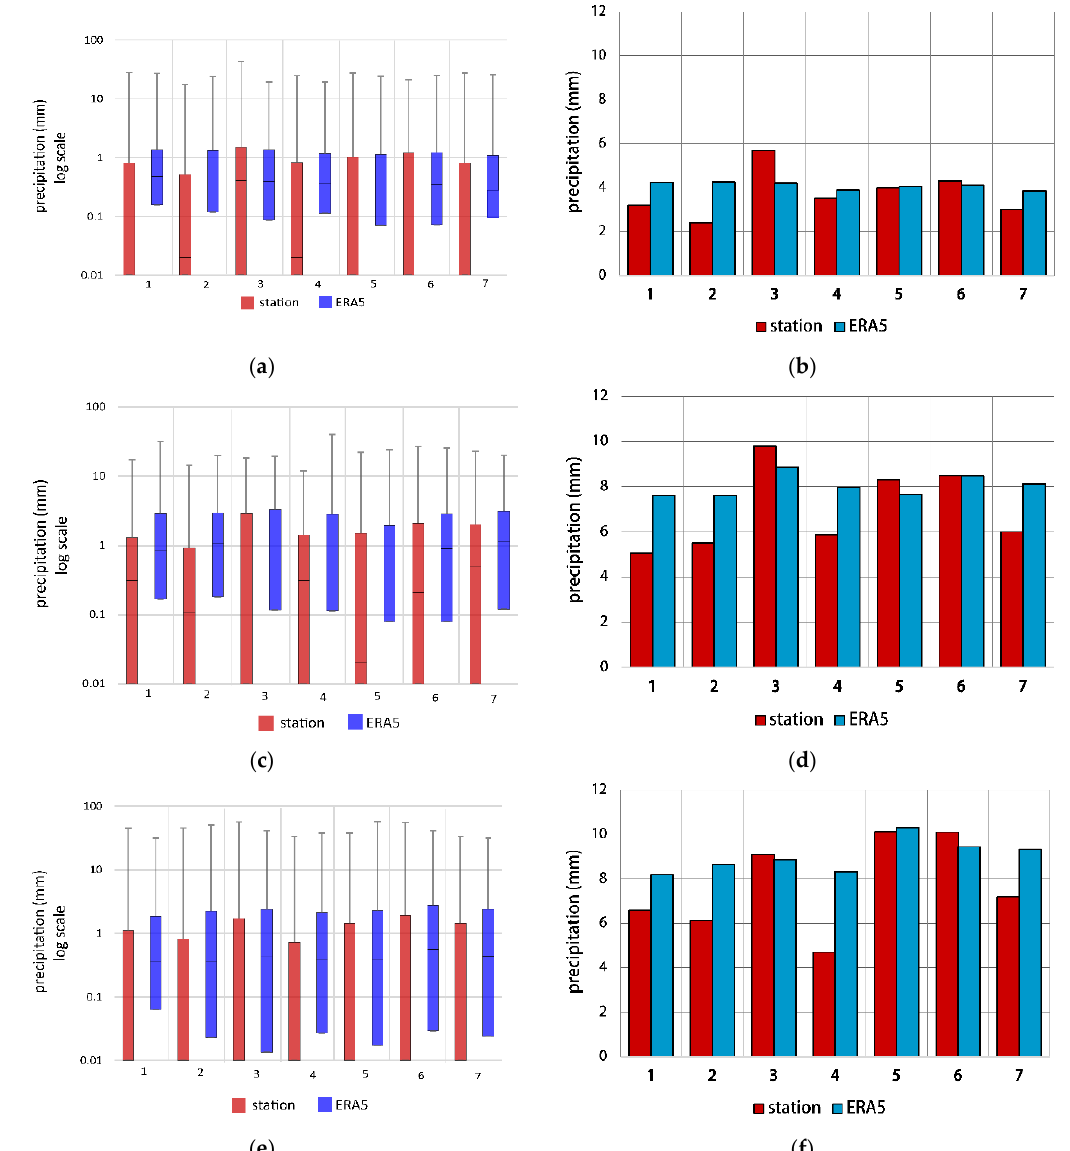
Figure 9. Whisker-box plot ( left column ) and 95th percentile ( right column ) of total daily precipitation for seven stations ( red ) and the nearest grid points of ERA5 reanalysis ( blue ) for cold ( a , b ), snow thaw ( c , d ) and summer rains ( e , f ) periods. Boxes indicate the lower and upper quartile. Horizontal line in each box represents the median t2m air temperature. Vertical lines extending from each box represent the minimum and maximum temperature recorded for that station.